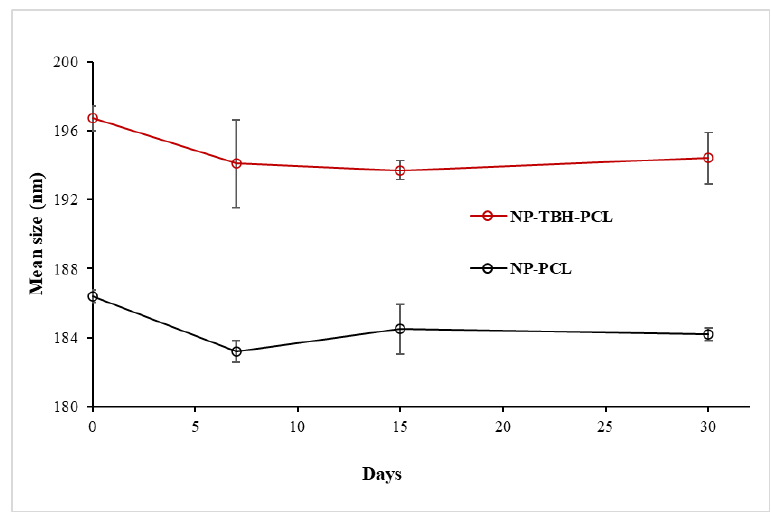
Figure 1. Stability study of the nanoparticle mean size (nm) over a month. Measures were taken at days 0, 7, 15 and 30. Results are shown as average ± SD. Some error bars are obscured by the symbols due to their small size.